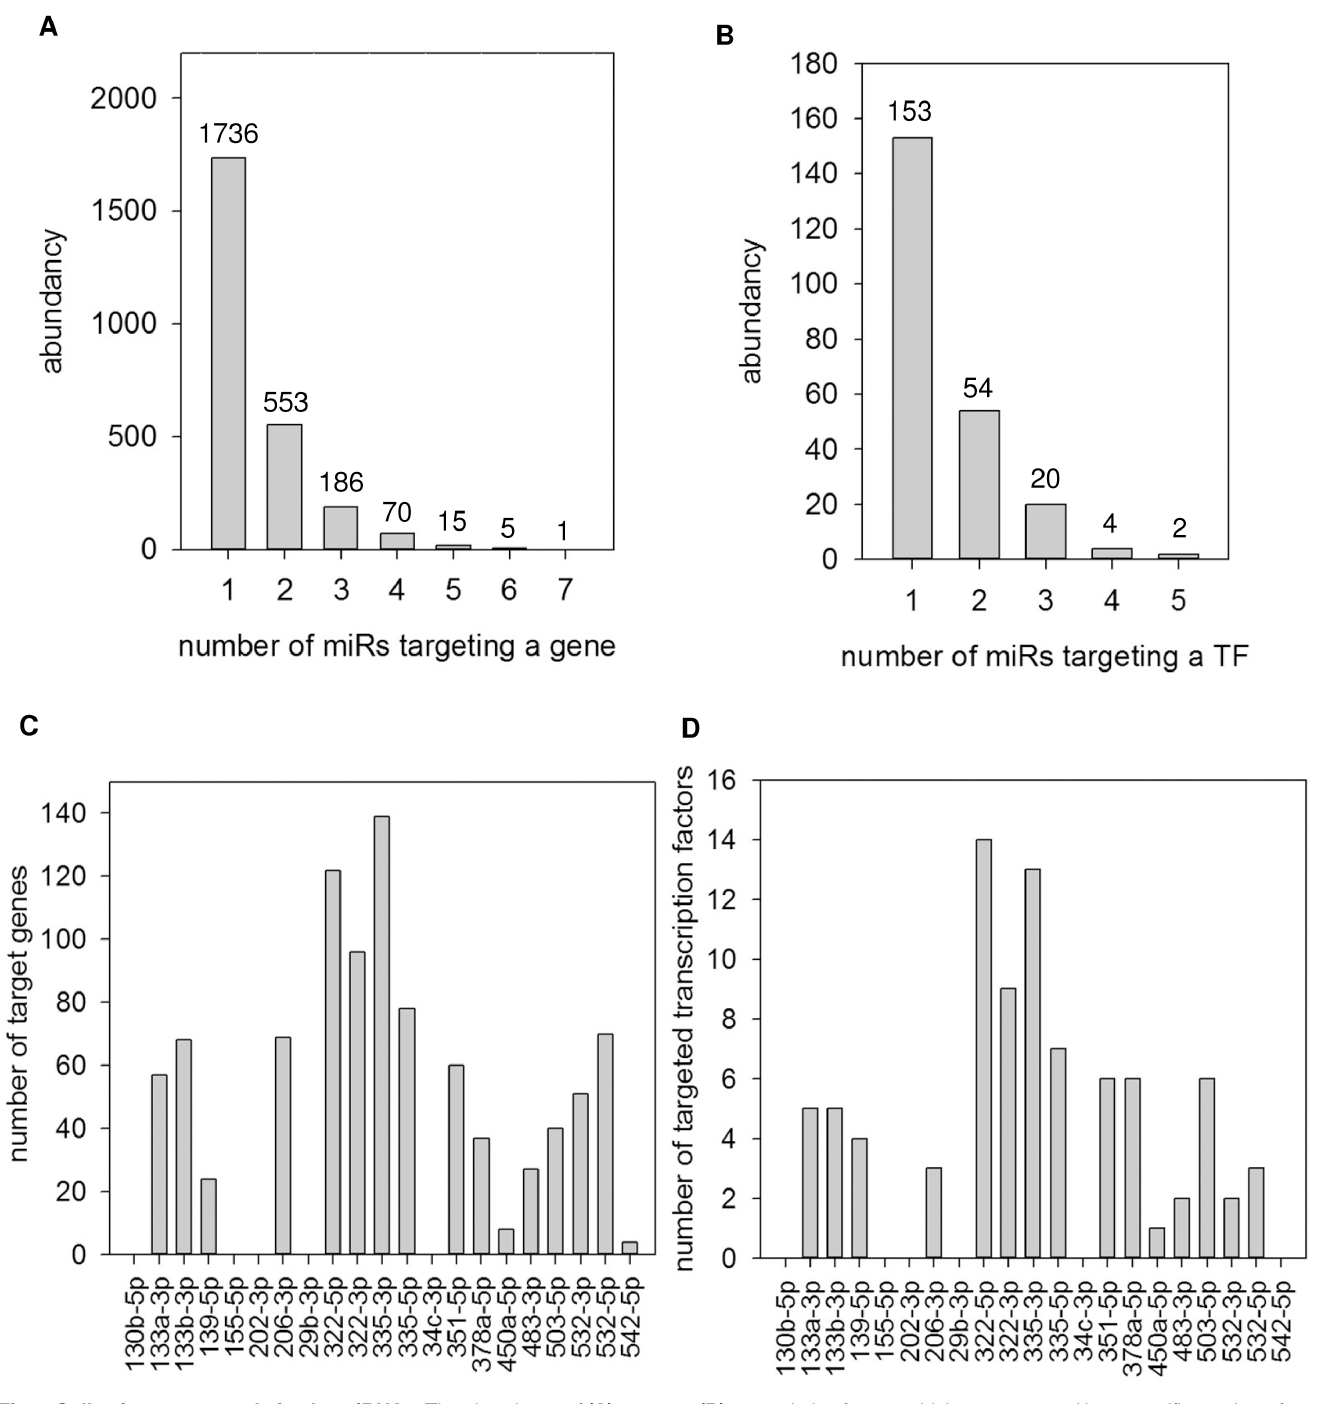
Fig 5. Collective target regulation by miRNAs. The abundance of (A) genes or (B) transcription factors which were targeted by a specific number of miRNAs of the observed miRNA set is shown. (C) The number of genes targeted by at least two other miRNAs (resulting in at least three miRNAs per gene) of the 21 miRNA-subset per individual miRNA and (D) the number of transcription factors targeted by at least two other miRNAs of the 21 miRNA-subset per individual miRNA are depicted. The abundance of miRNA-target interactions indicates collective target regulation by a subset of muscle expressed miRNAs.